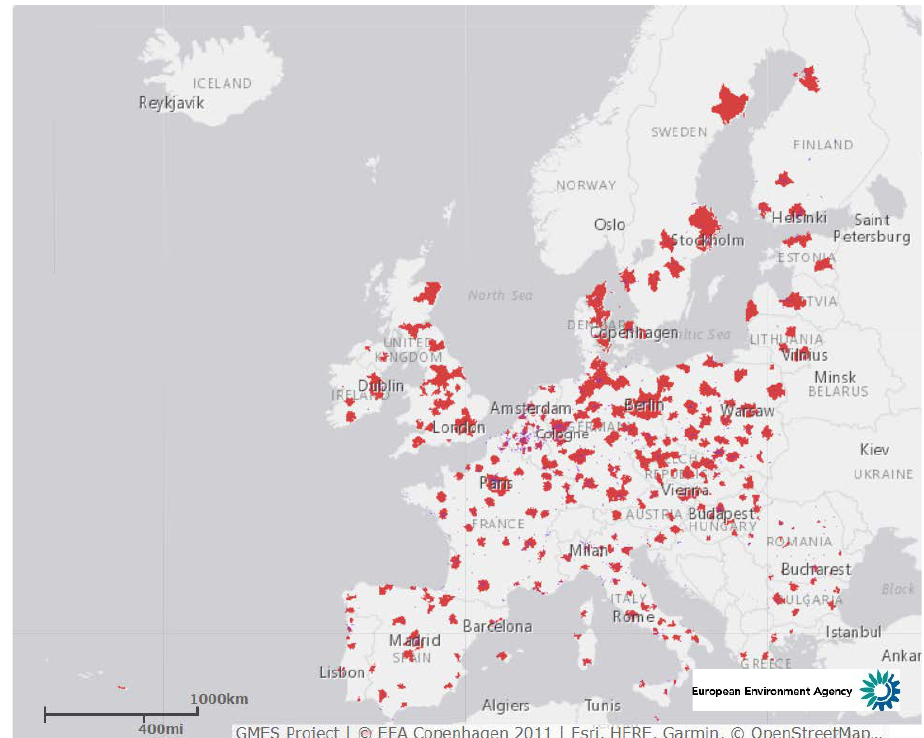
Figure 2. Coverages of EEA Urban Atlas in Europe. Red masked area shows the coverages of EEA Urban Atlas 2006 [18].